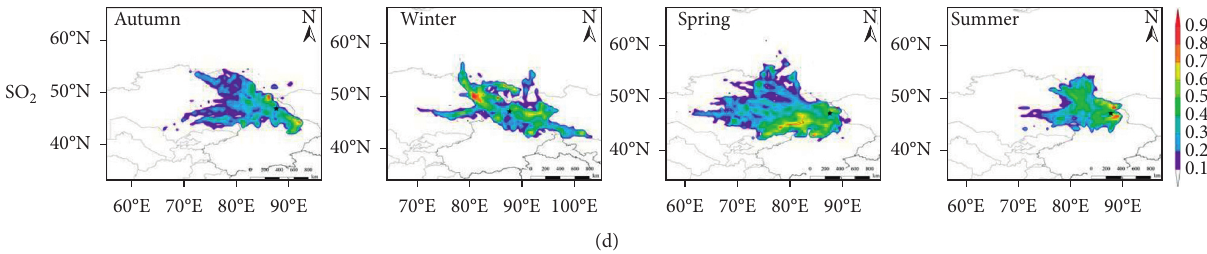
Figure 8: Seasonal distribution of the weighted potential source contribution function (WPSCF) of reactive gases in Akedala, from September 1, 2017, to August 31, 2018. The black star represents Akedala